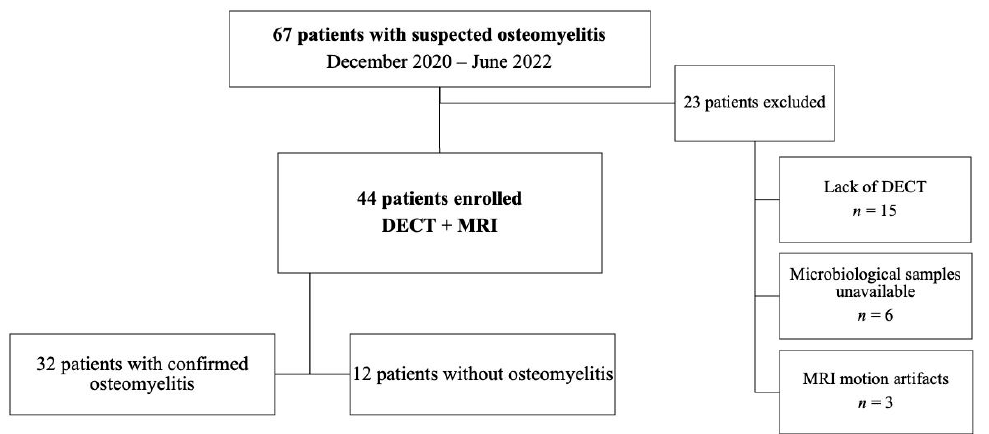
Figure 1. Flowchart of participants. DECT = dual-energy CT; MRI = magnetic resonance imaging.